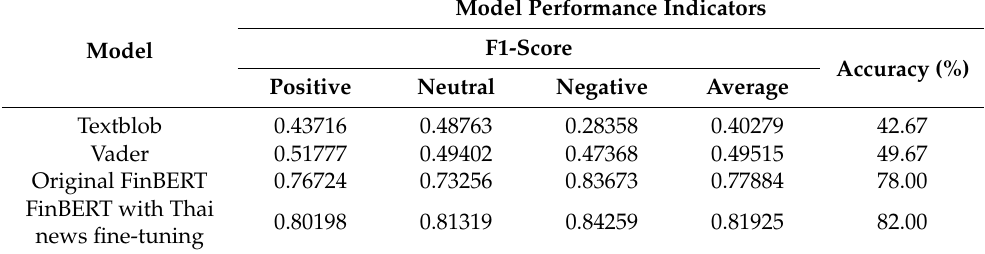
Table 3. Comparison results between the FinBERT with the Thai news model and other models for sentiment